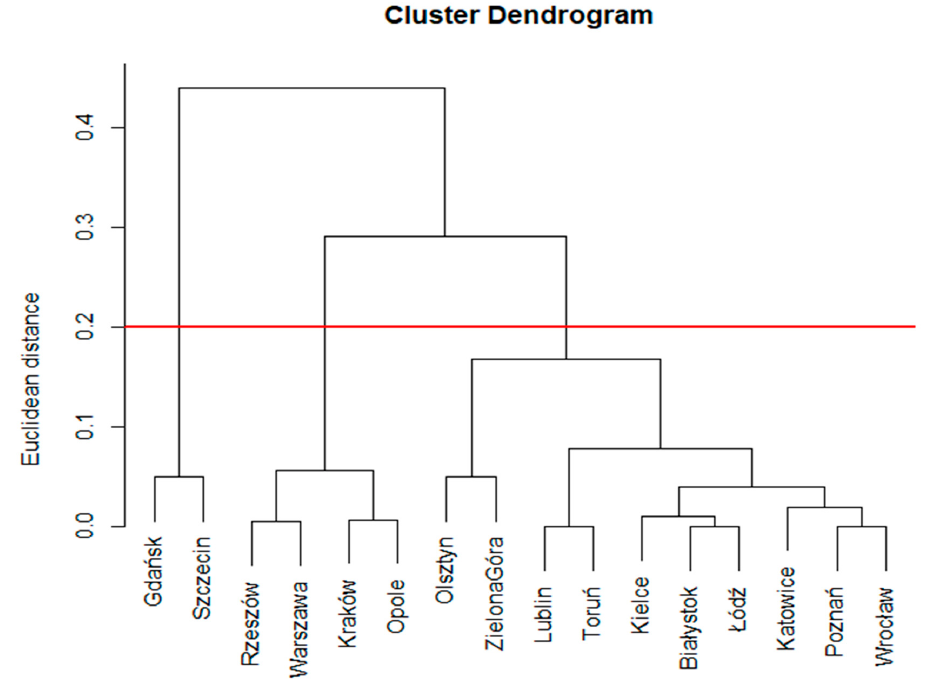
Figure 2. Grouping dendrogram based on the linolenic acid content predicted for the period of 2020–2039. The red horizontal line denotes the threshold value of the Euclidean distance at the end step of the grouping method.